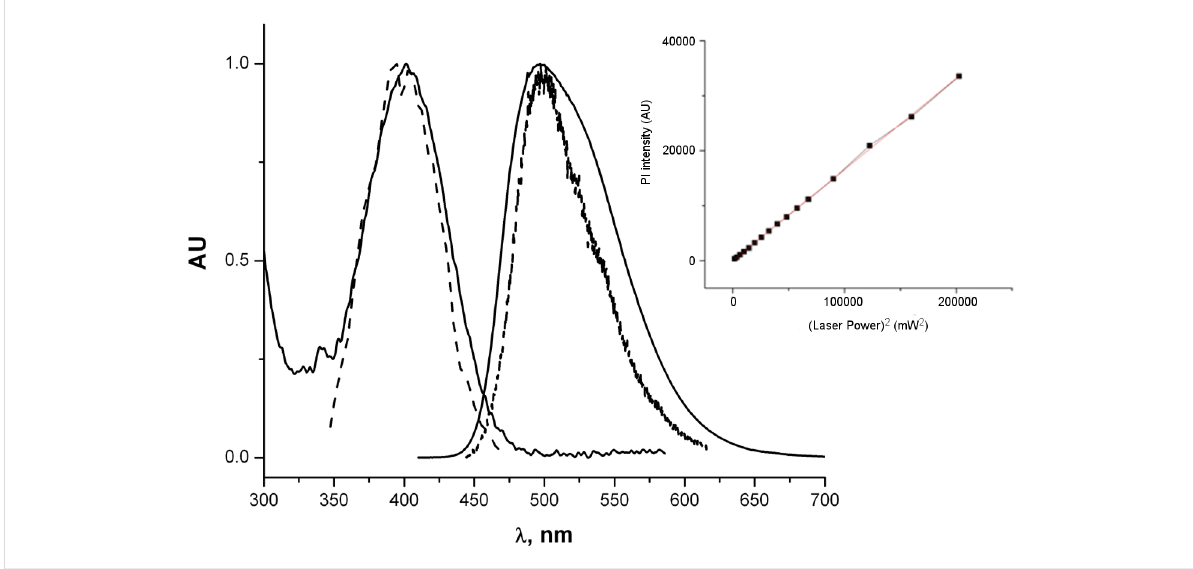
Figure 5: Normalized one- and two-photon spectra of dye 4 in toluene. Solid curves: one-photon absorption and fluorescence; dashed curves two- photon fluorescence excitation (the X-axis values are λ /2) and fluorescence spectra. Inset: fluorescence intensity versus (laser power) 2 at 800 nm.